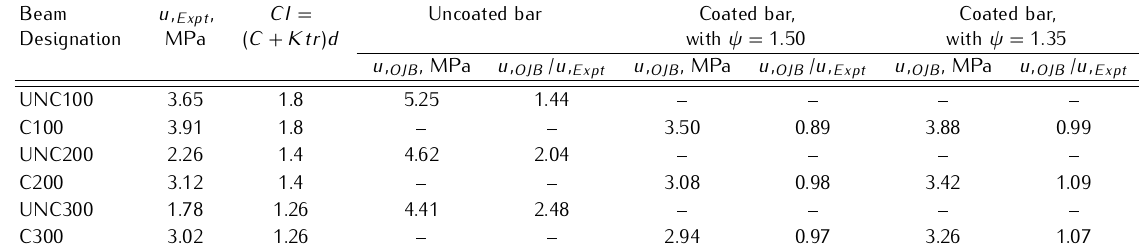
Table 7. Test/OJB predicted ratio of bond